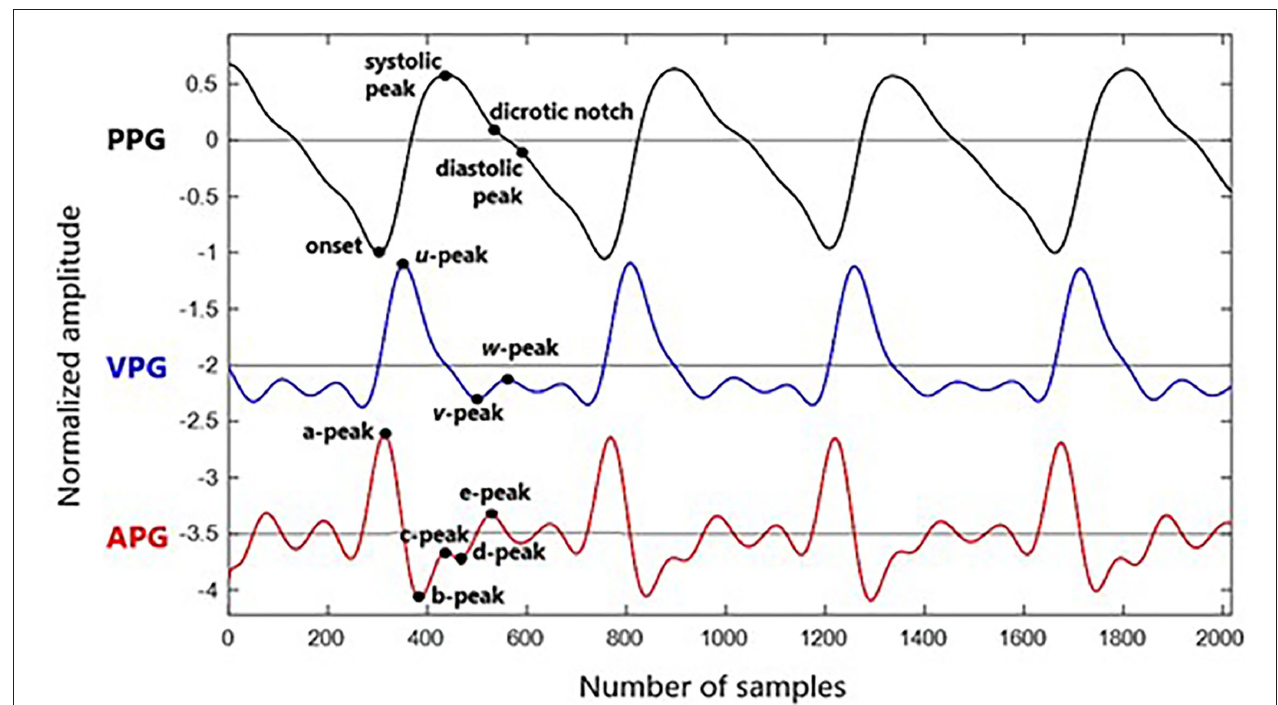
FIGURE 2 | Fiducial points of PPG, VPG, and APG